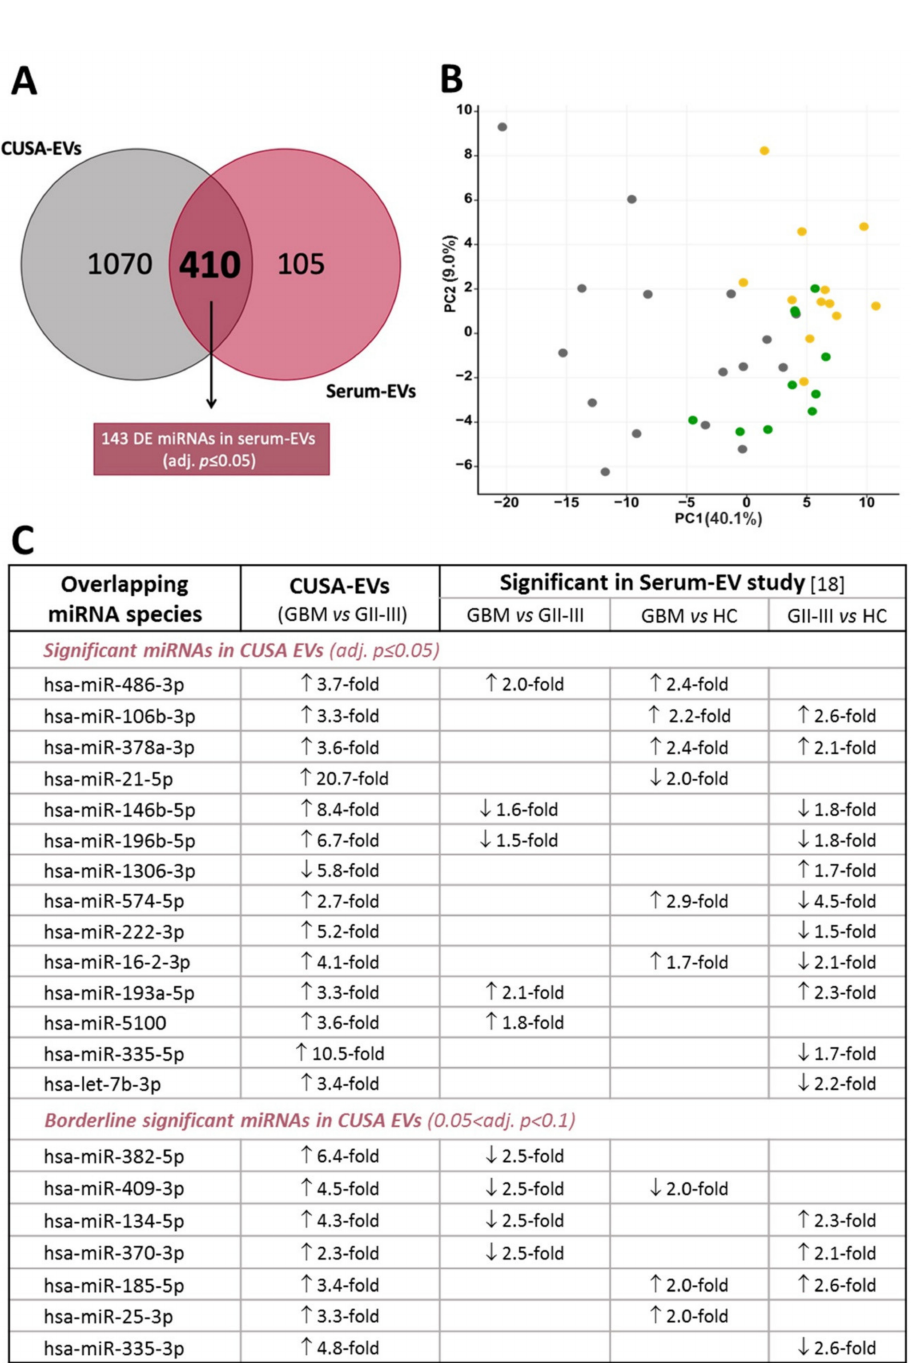
Figure 3. miRNA species in glioma-EVs captured from both CUSA fluid and serum. ( A ) Venn diagram showing the overlap of miRNAs detected in CUSA-EVs (average UMI count ≥ 10 in both GBM and GII-III) and serum-EVs (average read count ≥ 5 in at least two of three cohorts [GBM, GII-III and healthy controls; HC]). The Oasis 2.0 analytical pipeline was used to perform di ff erential expression analyses and identified 143 significant miRNAs in serum-EVs (adjusted p ≤ 0.05; pairwise comparisons). ( B ) Principal component analysis plot shows the clustering pattern for GBM (yellow, n = 12), GII-III (green, n = 10) and HC (grey, n = 16) in serum-EVs, based on the expression of 143 di ff erentially expressed overlapping miRNAs; the proportion of variance is explained by PC1 ( x -axis) = 40.1% and PC2 ( y -axis) = 9.0%. ( C ) Summary table of overlapping significant DE miRNAs in both CUSA-EVs (GBM vs. GII-IIIl) and serum-EVs (pairwise comparisons). Arrows depict direction of miRNA fold